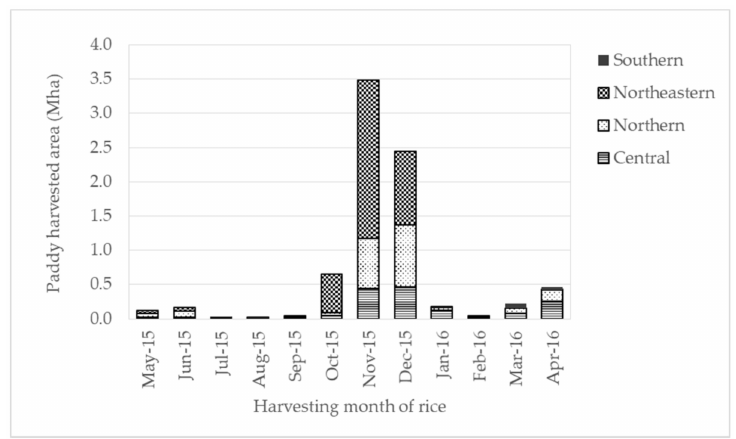
Figure 4. Monthly distribution of paddy harvested area in Thailand categorized by region during the crop season of